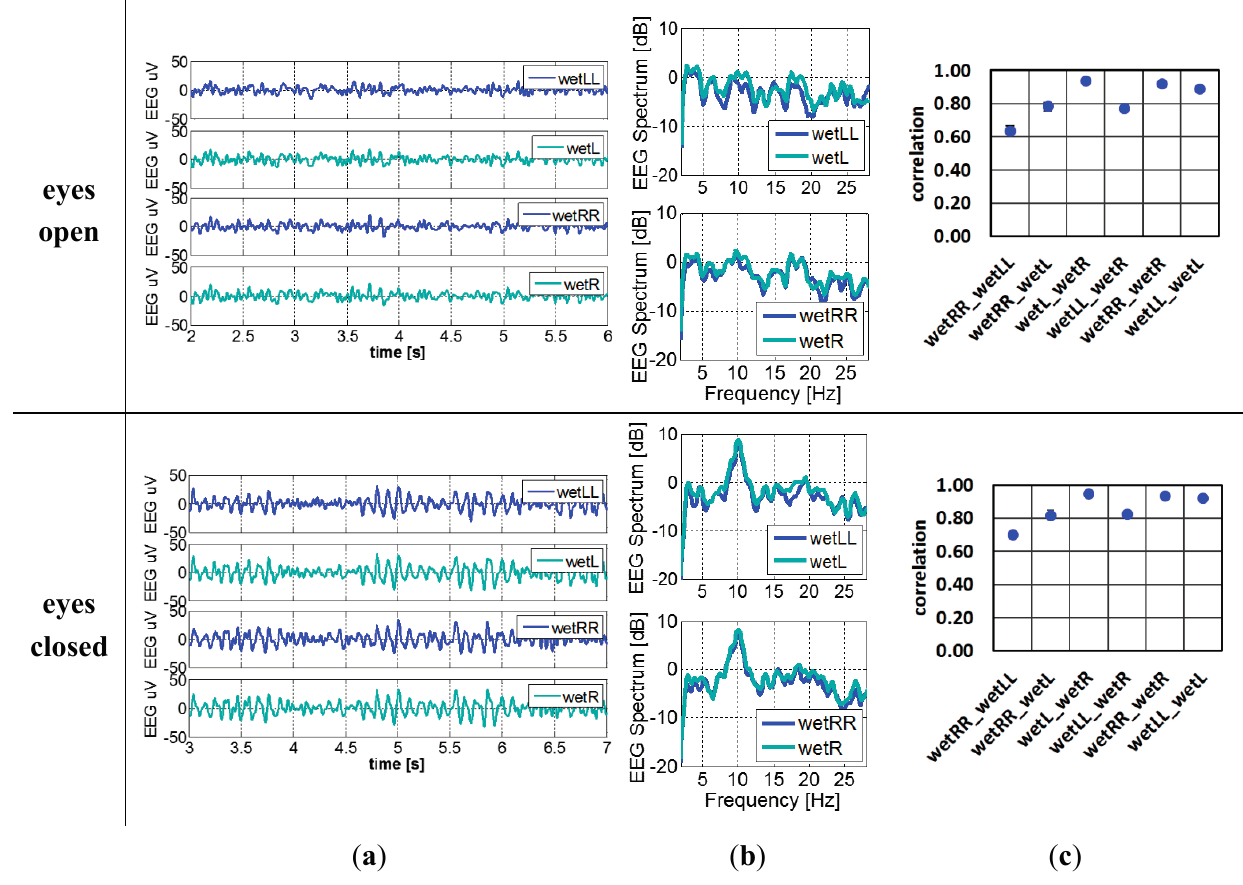
Figure 11. ( a ) Filtered EEG signals; ( b ) EEG spectrum; ( c ) Averaged correlation of reference recording when the eyes of subject were open and